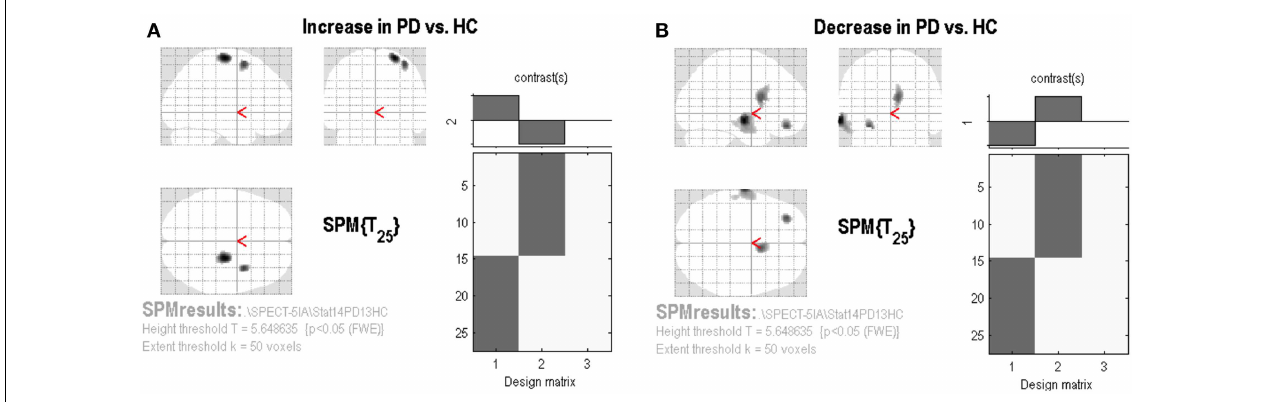
FIGURE 2 | Statistical parametric mapping results . Group contrast giving relative increase (A) or decrease (B) in [ 123 I]5IA uptake in PD patients applying the proportional scaling global mean, thresholded at p < 0.05 and corrected for